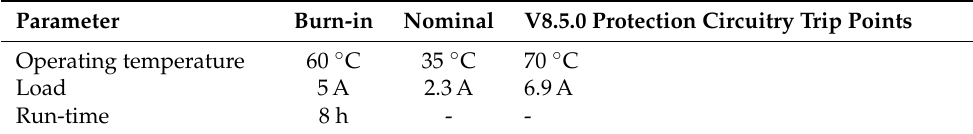
Figure 5. Functional block diagram of an LVPS Brick. Table 1. Preliminary Phase-II upgrade Brick burn-in parameters, nominal Brick operating parameters and relevant protection circuitry trip